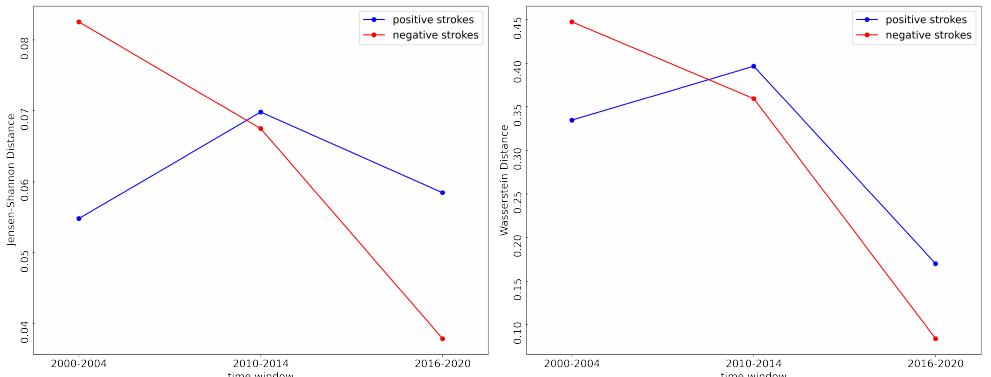
Figure 6. Agreement with Benford’s law for the number of positive and negative strokes per day (lower is better). ( Left panel ) Jensen–Shannon distance; ( right panel ) Wasserstein distance.